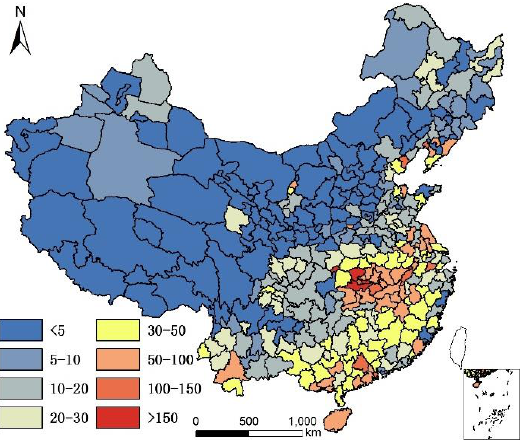
Figure 10. Per capita freshwater-fish production of each city in China in 2016 (kg).